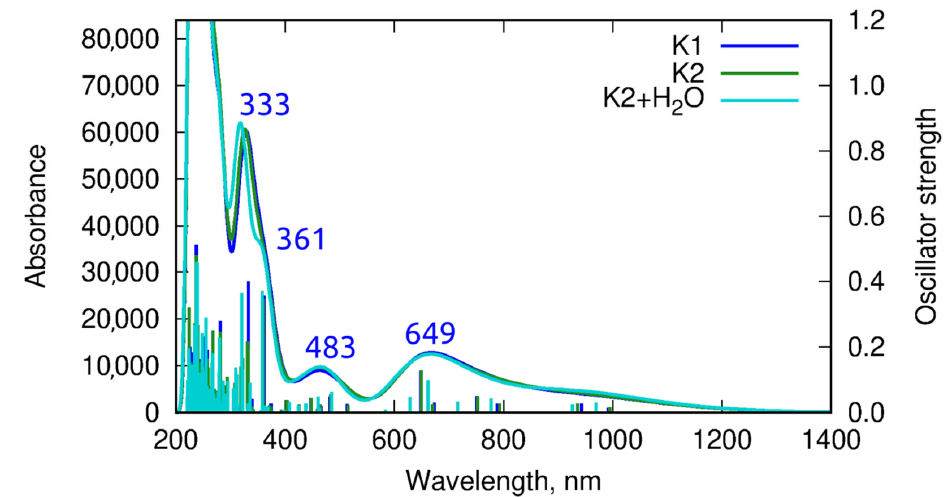
Figure 12. Vertical absorption spectrum for K1 , K2, and K2 with one water molecule, estimated within the ω B97X-D/def2-SVP/PCM(CHCl 3 ) approach (the sticks represent the position and the corresponding oscillator strength for the subsequent excitations, and the curve is the fit to these data).